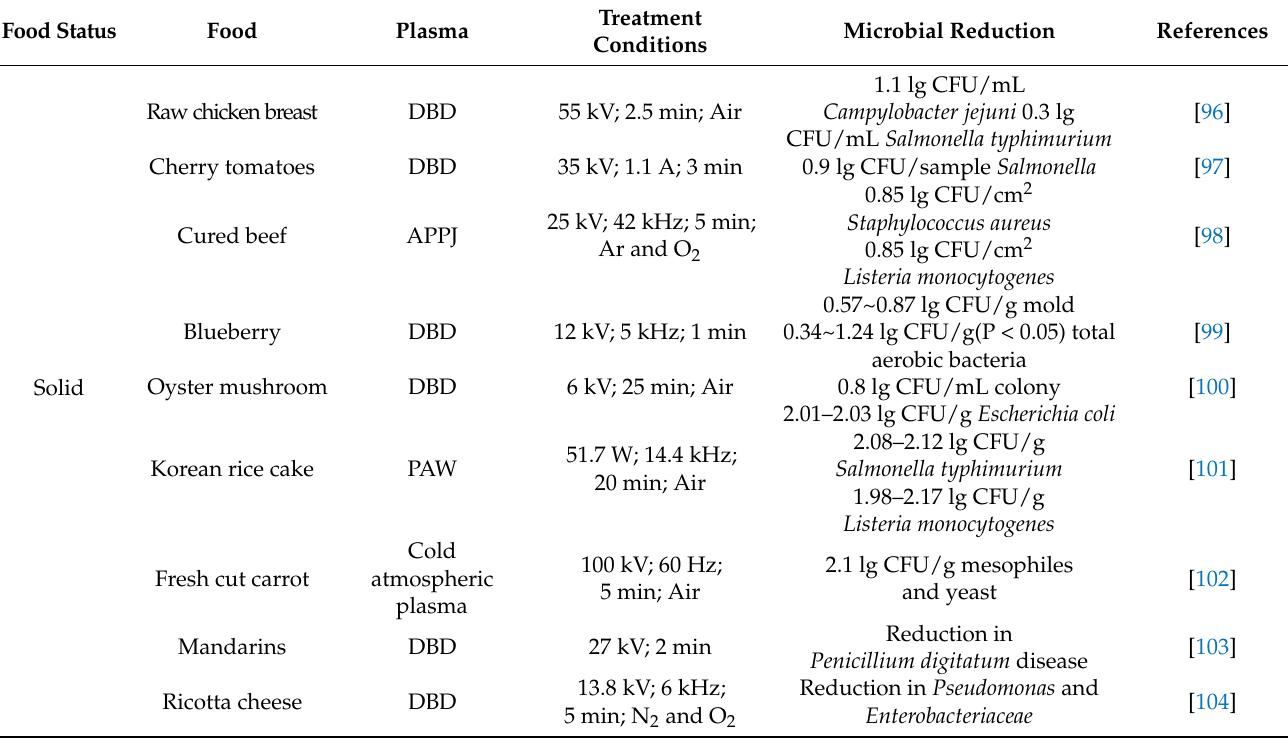
Table 2. Recent findings on microbial inactivation of various food products using CP